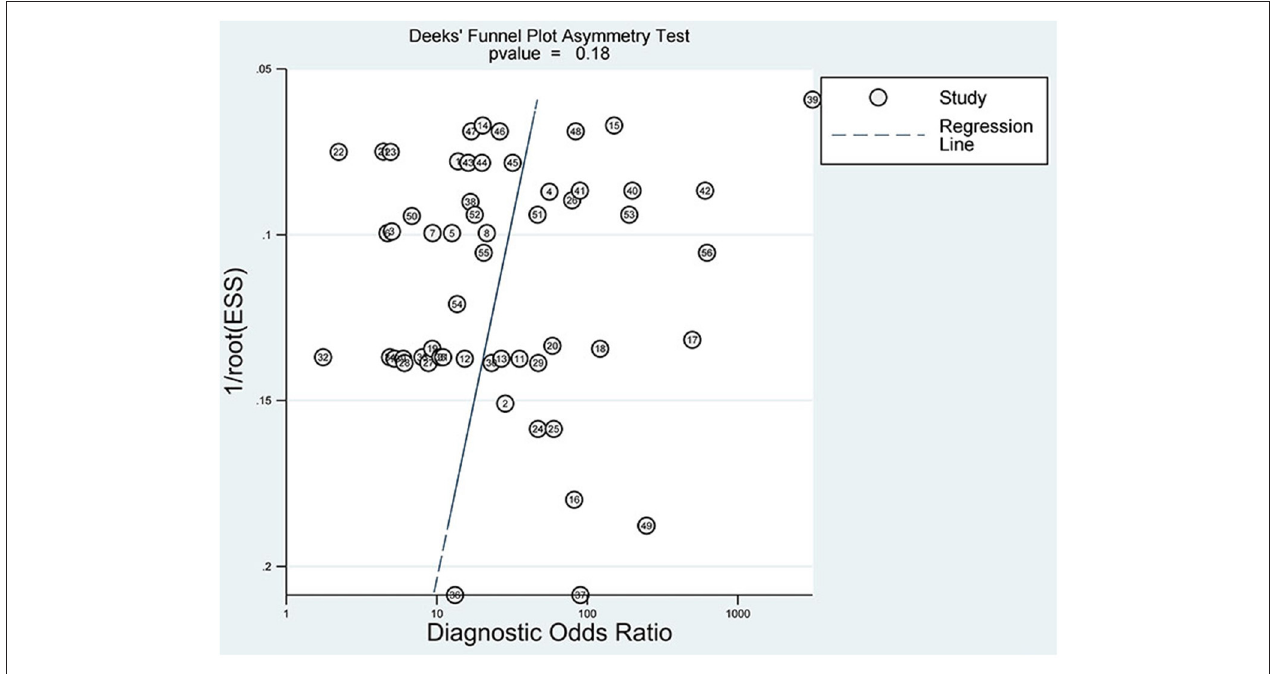
FIGURE 9 | Funnel plot of publication